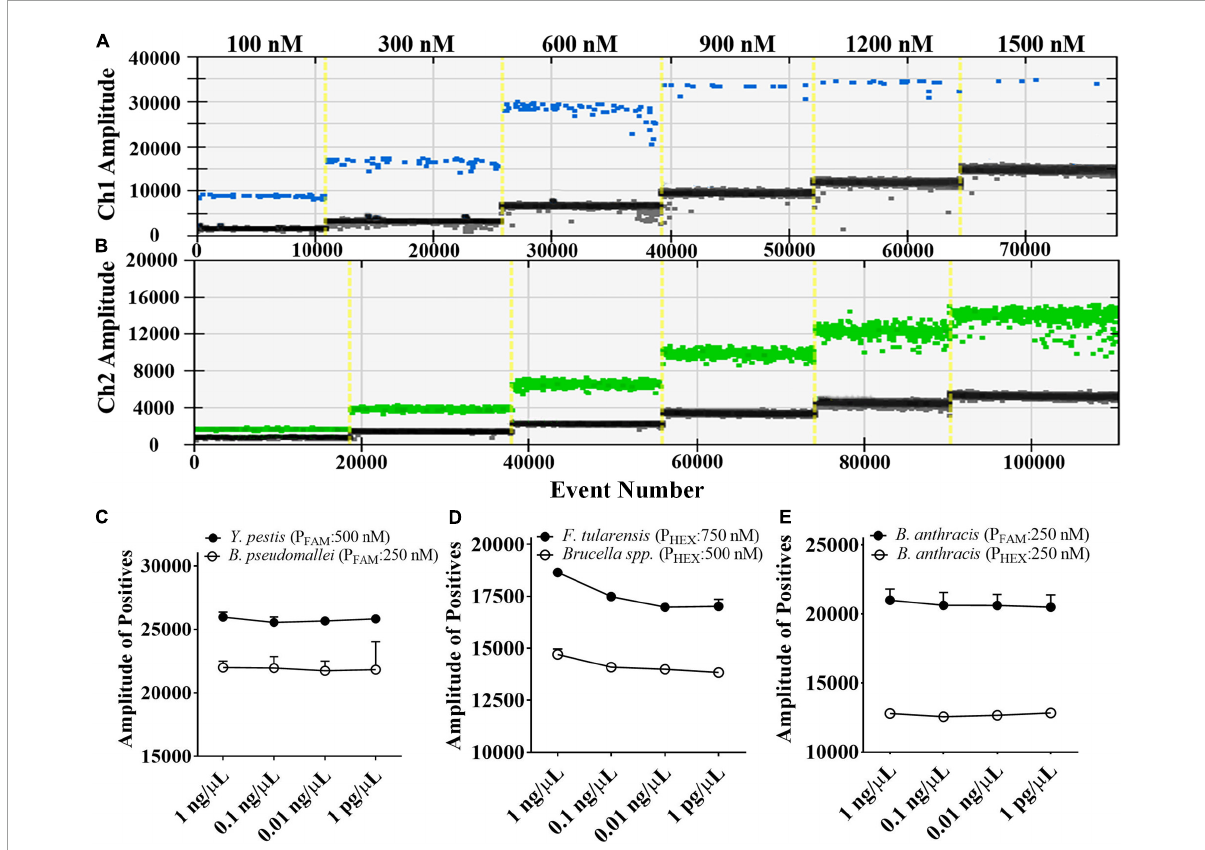
FIGURE2 Fluorescence amplitude of ddPCR mixtures containing different concentrations of FAM-labeled probes (A) and HEX-labeled probes (B) , and the fluorescence amplitude corresponding to serial diluted DNA samples (1 pg/ µ L to 1 ng/ µ L) under the optimized probe concentrations (C–E) .